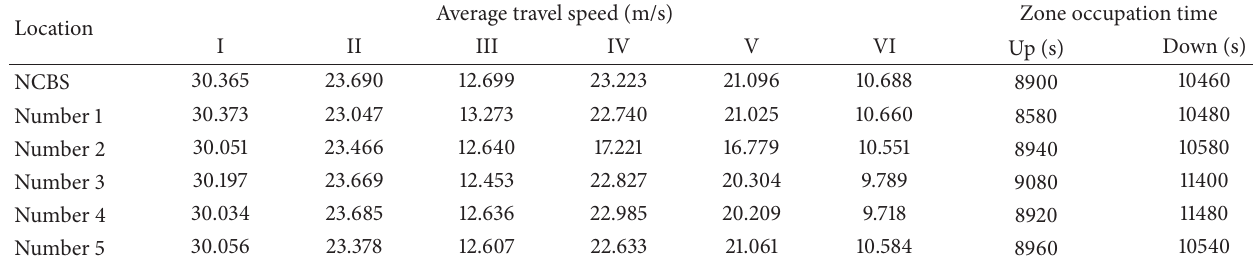
Table 2: Results for different NCBSs setting